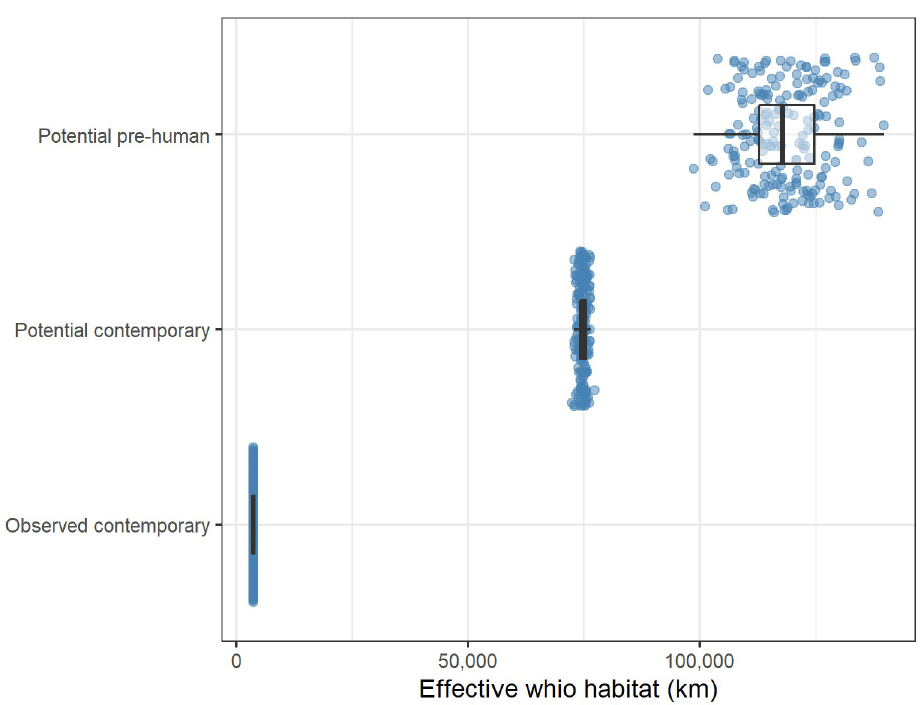
Fig 5. Availability of predicted effective whio habitat under three scenarios. Effective whio habitat is the sum of the predicted relative likelihood of occurrence for each reach x reach length prior to human arrival in New Zealand (potential pre-human), in contemporary habitat with the exclusion of predators (potential contemporary) and the observed distribution (observed contemporary). Potential values represent predictions from 200 bootstrapped simulations of a boosted regression tree model, while observed contemporary values are the potential contemporary predictions at reaches where whio were observed from 1979–2016. Boxplots show the median (solid line) and quartiles with whiskers reaching up to 1.5 times the interquartile